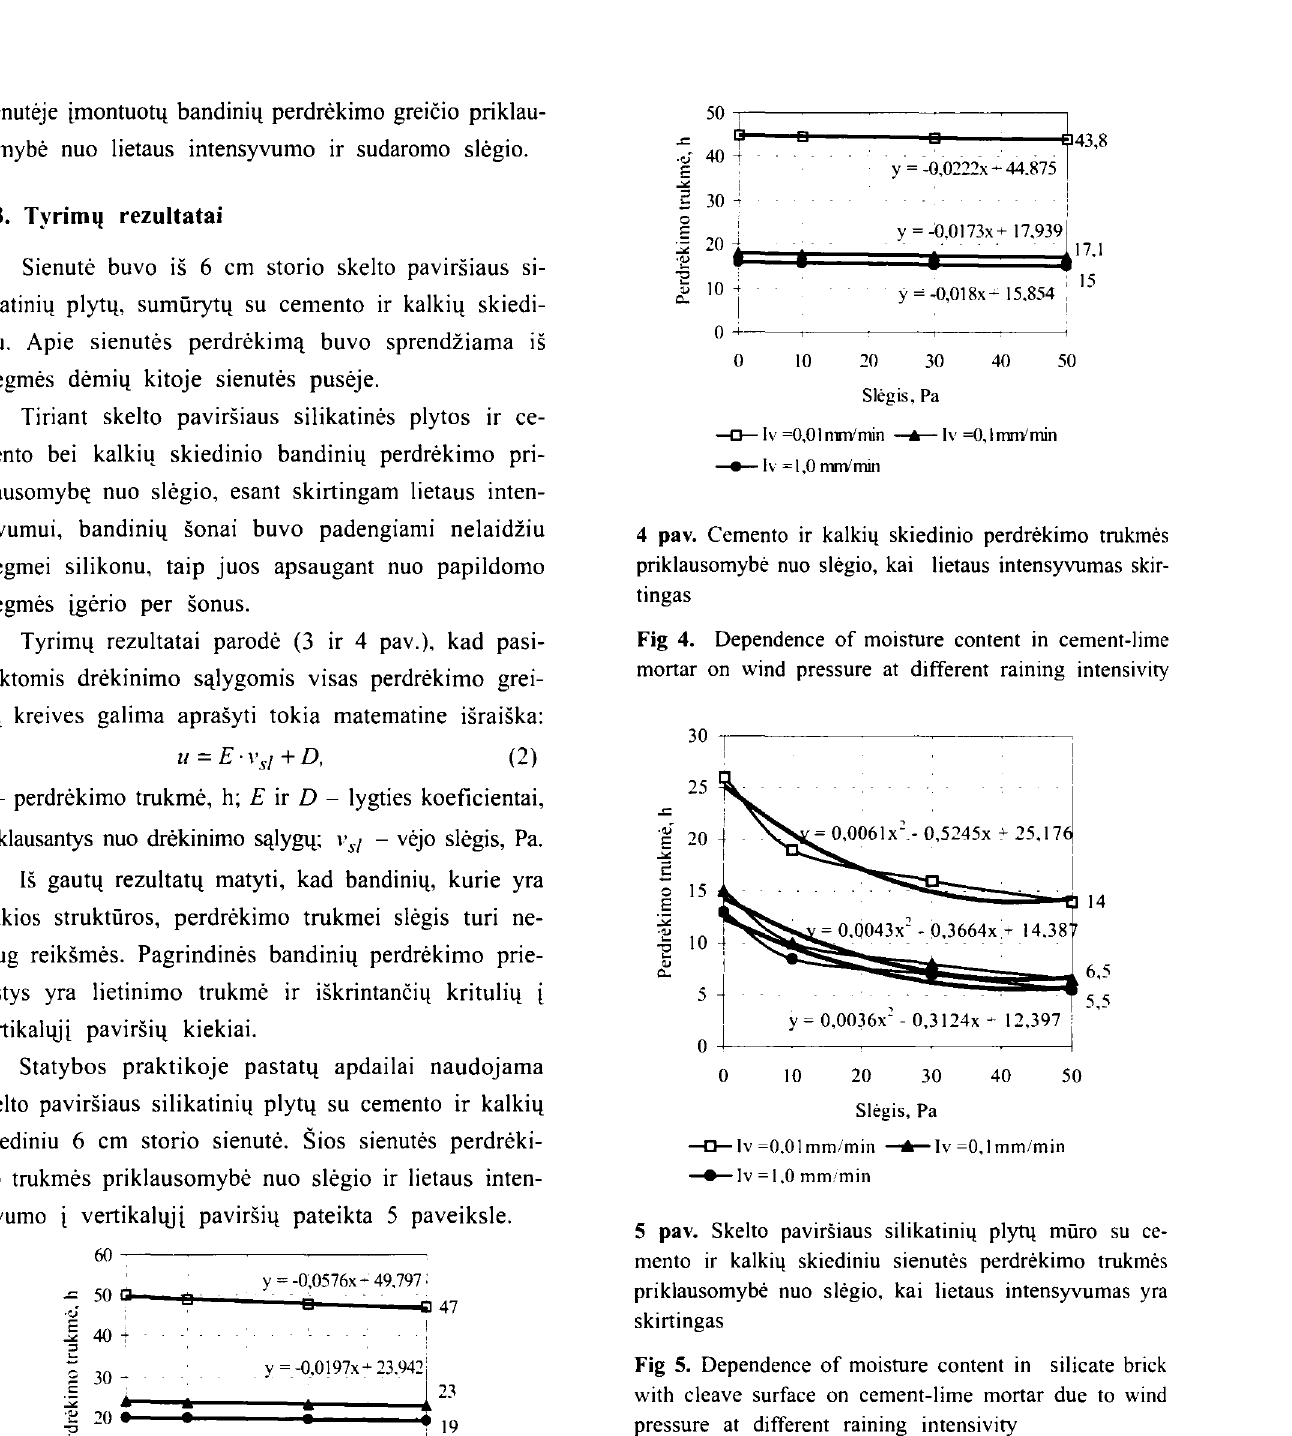
Fig 5. Dependence of moisture content in silicate brick with cleave surface on cement-lime mortar due to wind pressure at different raining intensivity Pasirinktomis drekinimo Sillygomis visas perdre kimo greici4 kreives galima aprasyti tokia matematine